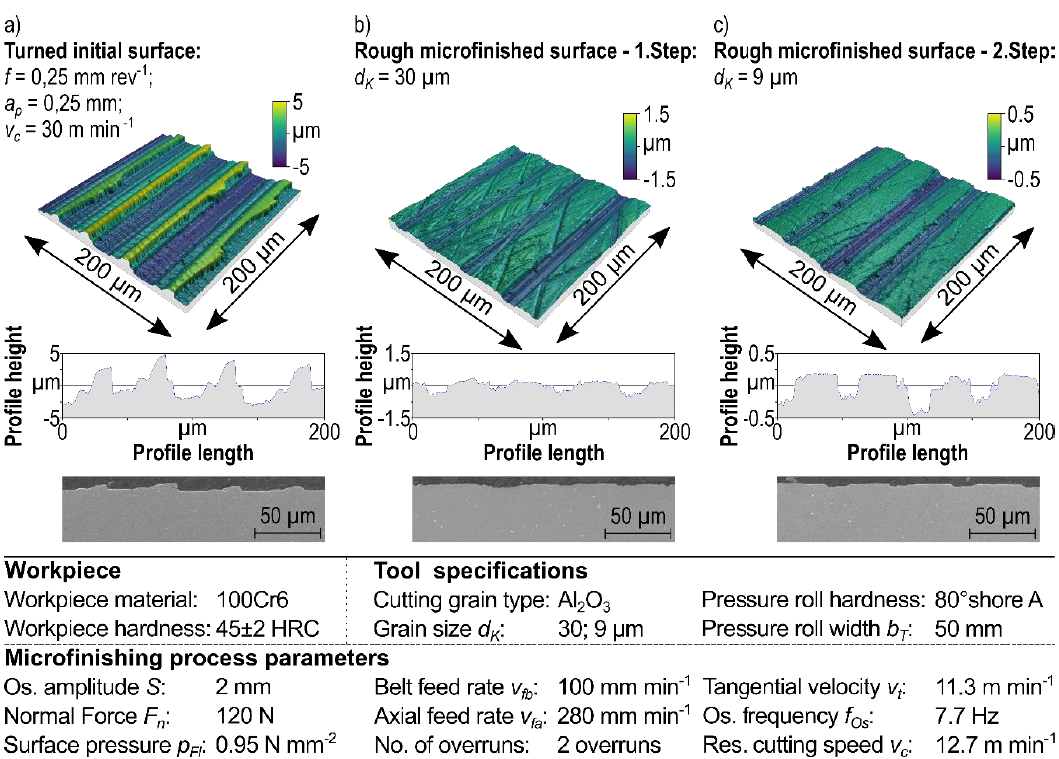
Figure 12. Topography, detailed profile, and cross section SEM picture for the machining steps ( a ) turned, ( b ) first rough microfinishing step, and ( c ) second rough microfinishing step.